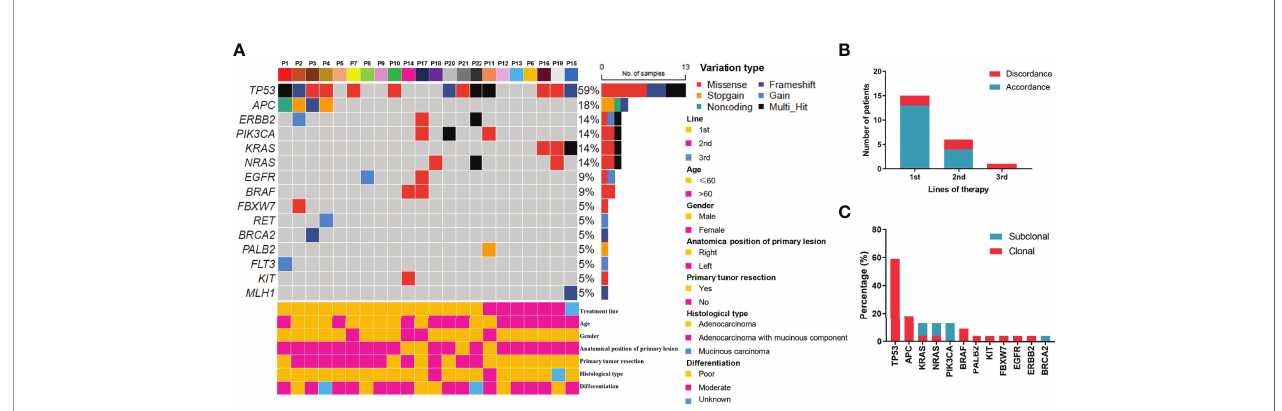
FIGURE 1 | Mutation pro fi ling of pre-treatment ctDNA. (A) Genomic pro fi les of 22 advanced colorectal cancer patients from pre-treatment ctDNA. (B) The consistency of the RAS mutations detected in paired tissues and plasma. (C) The clonal and subclonal landscapes in 22 mCRC patient at baseline. Gain: segments with log ratio more than 3 times of standard deviation of all segment level were considered as “ gain ”